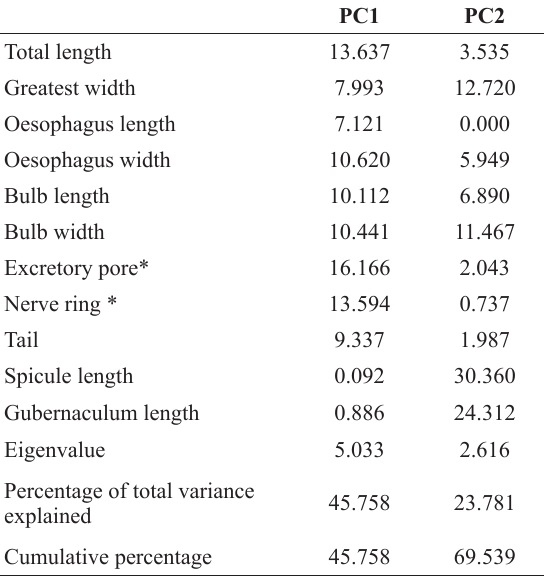
Results of a principal component analysis of morphometric variables of females of A. hylambatis